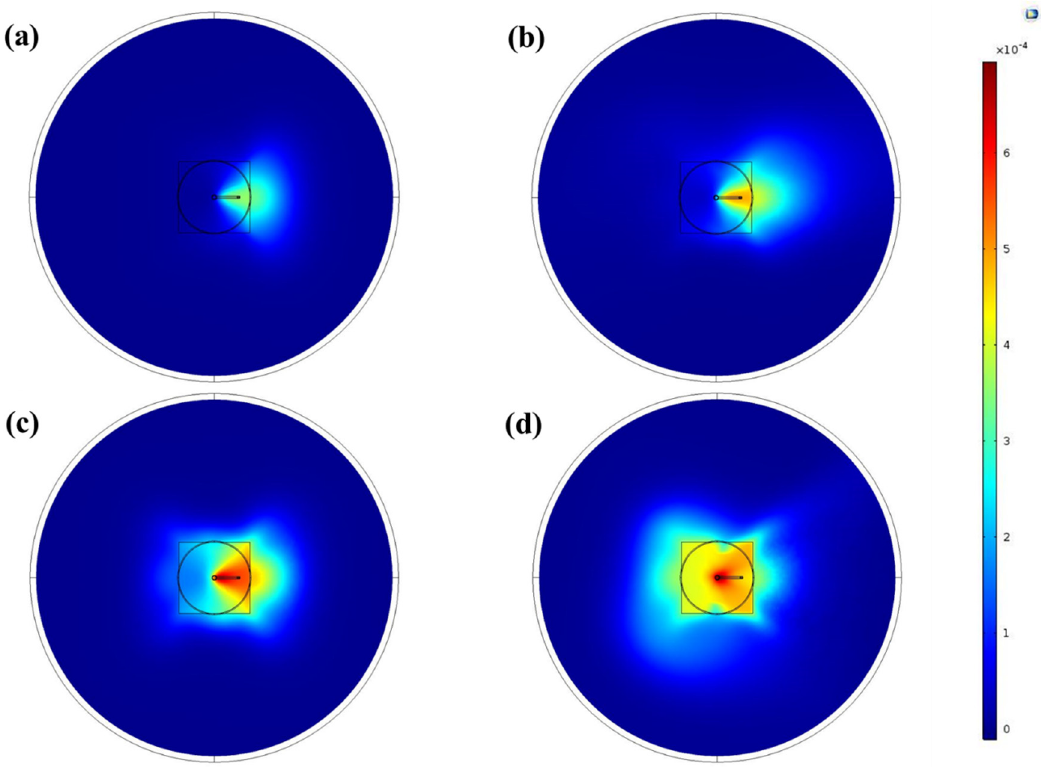
Figure 6. Top view (XY-plane) of the monomer mass fraction distribution at 5 mm gap size for ( a ) 125 sccm, ( b ) 250 sccm, ( c ) 500 sccm, and ( d ) 750 sccm side gas flow rates.